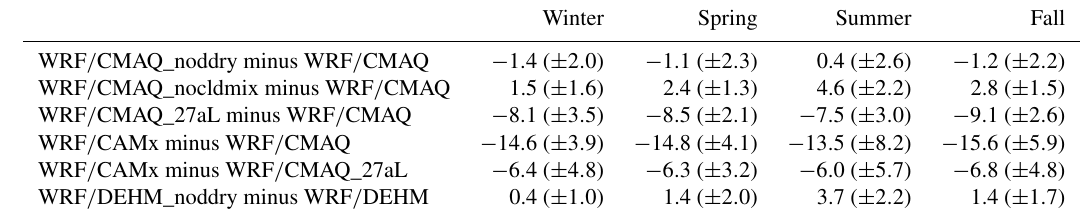
Table 4. Differences in seasonal averaged DM8A BC1 / BCT (%) between simulations after averaging over all land grid cells over the analysis domain. Values in parentheses are the standard deviations of the differences between simulations over land.